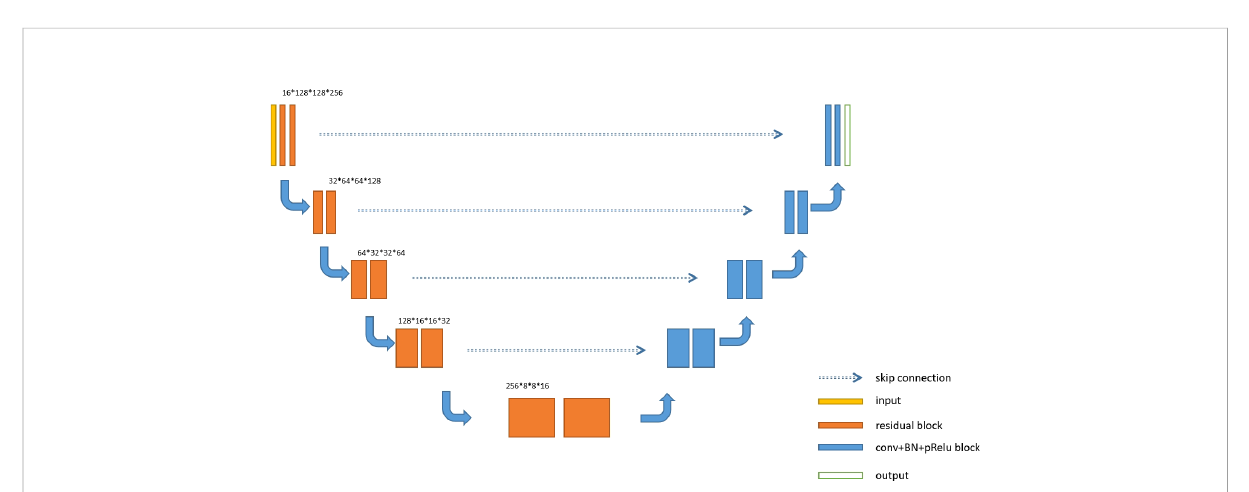
FIGURE 4 Res-UNet architecture.